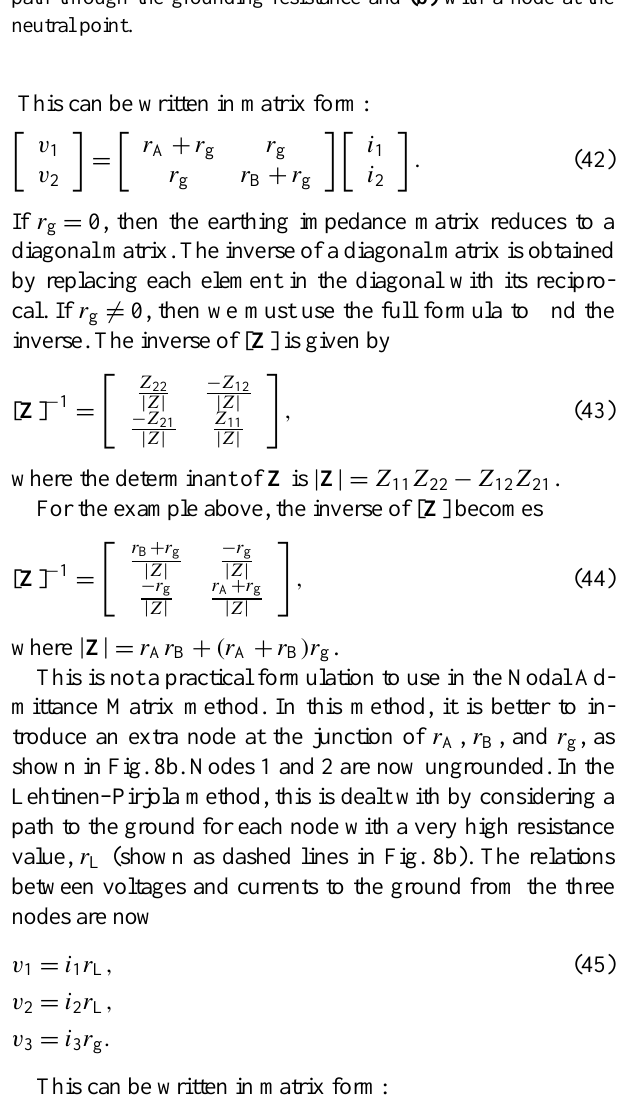
Figure 7. Network model for a substation, as in Scenario 3, con- nected to transmission lines to substations with a single path to the ground.